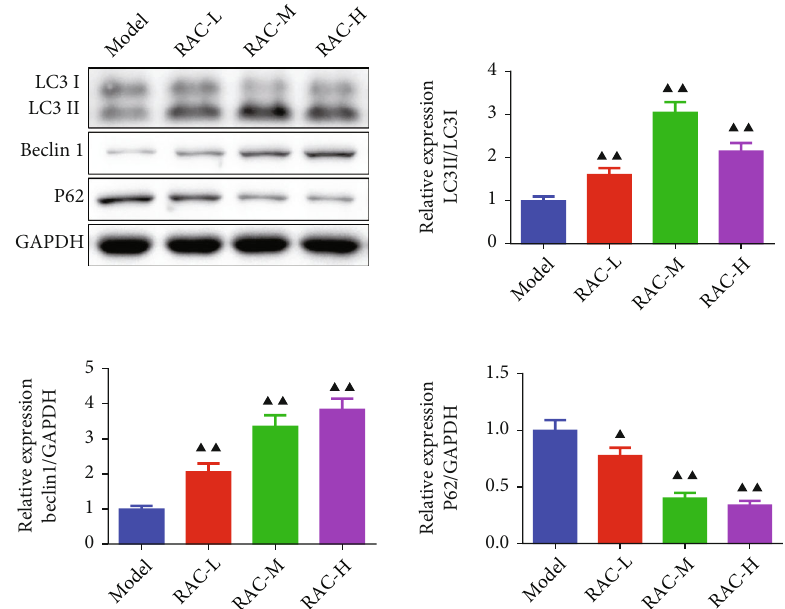
Figure 7: RAC induced the autophagy of the tumor cell in RCC mice. The protein expression of LC3, Beclin 1, and P62 was measured by western blot. ▲ P < 0 : 05 and ▲▲ P < 0 : 01 vs. the model. Results were presented as mean ± SD . n = 3 . Note: RAC: Radix Actinidia chinensis; RCC: renal cell